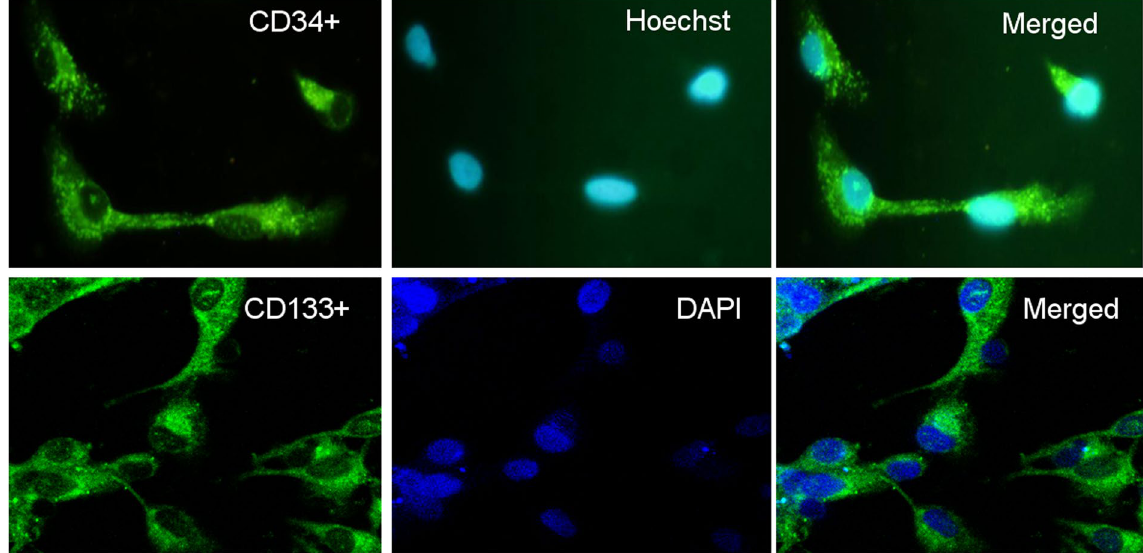
Figure 3. Identification of EPCs. After seven days of culture, the cells were labeled with fluorescent antibodies against CD34 or CD133, and positive staining was seen in the cultured EPCs.